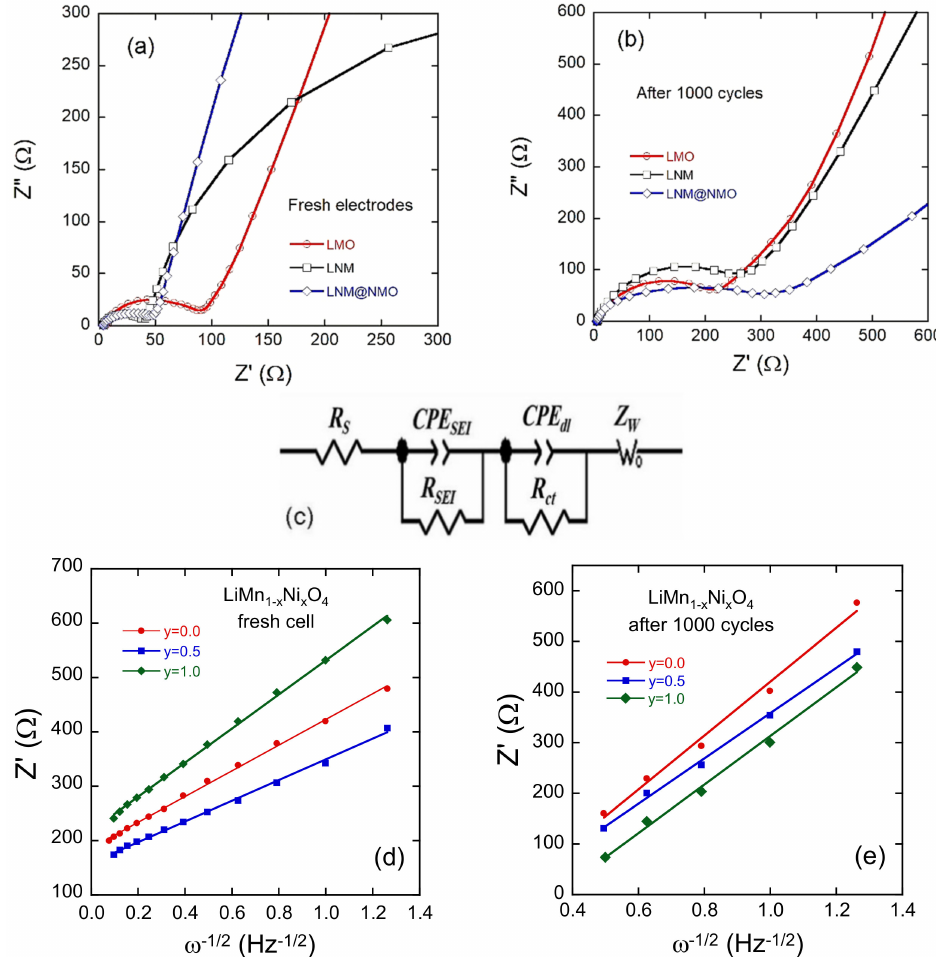
Figure 9. EIS measurements (Z” vs. Z’ plots) of LiNi y Mn 2 − y O 4 ( y = 0, 0.5 and 1.0) electrodes: ( a ) Fresh electrodes, ( b ) after 1000 cycles at 1C. ( c ) Plots of the real part of the impedance vs. ω − 1/2 for ( d ) fresh electrodes and ( e ) after 1000 cycles. The inset presents the equivalent circuit. Table 5. Fitting results of Nyquist plots for the LiNiyMn 2 − y O 4 (y = 0, 0.5 and 1.0) electrodes before cycling and after the 1000th cycle: cell resistance R s , SEI resistance R SEI , charge-transfer resistance R ct and diffusion coefficient D Li+ .